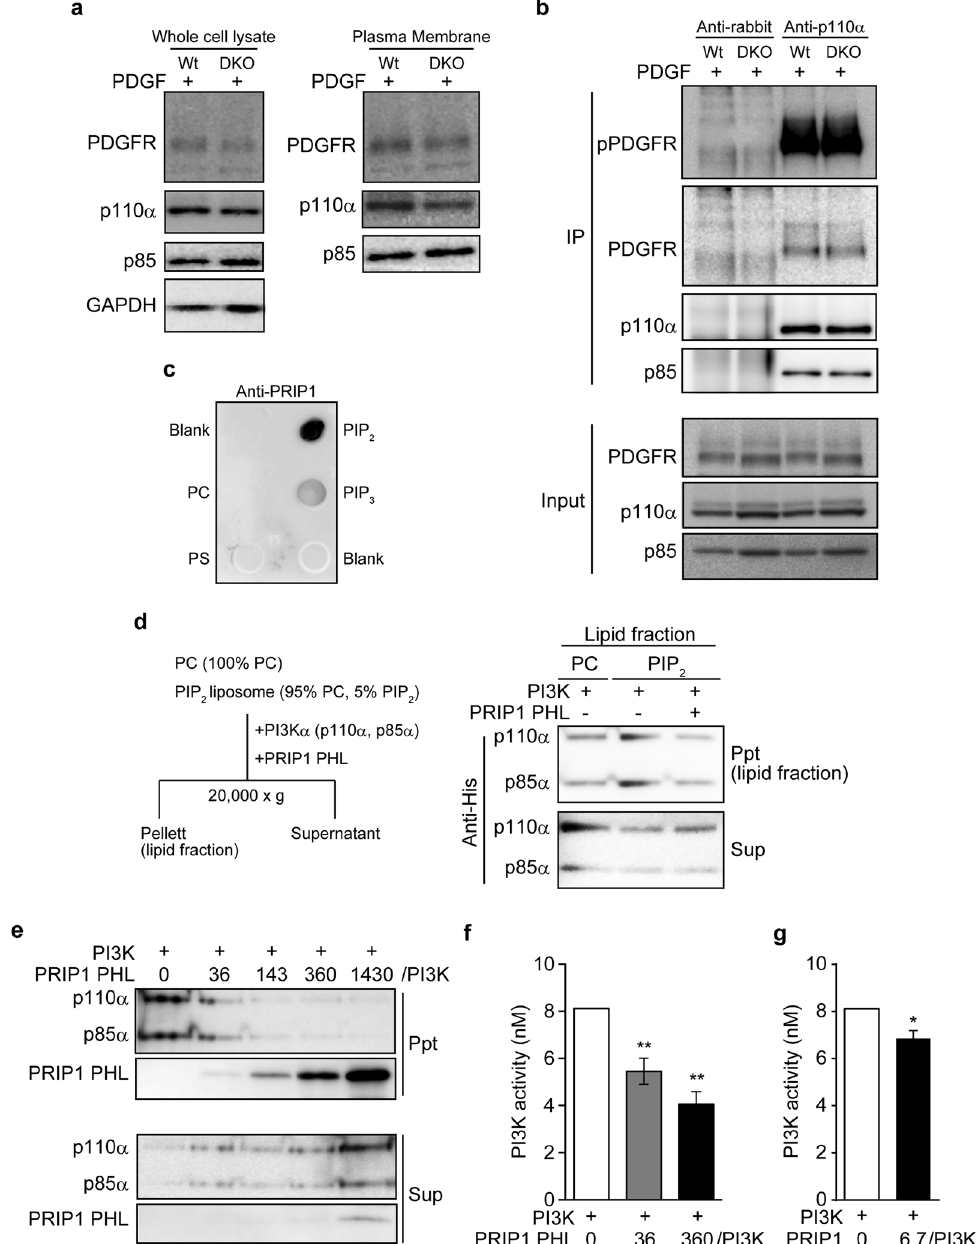
Figure 7. PRIP suppresses the conversion of PI(4,5)P 2 to PI(3,4,5)P 3 by PI3K. ( a , b ) MEFs were stimulated ( + ) with 20 ng/mL PDGF for 10 min. Treated cells were homogenised and fractionated by centrifugation ( a ) or lysed and immunoprecipitated (IP) with an anti-p110 α antibody ( b ). Western blotting was performed with the indicated specific antibodies. Similar data were obtained from at least three independent experiments, and a set of representative images is shown. ( c ) Specific binding of EGFP-PRIP1 to PI(4,5)P 2 . Indicated lipids were blotted on a polyvinylidene difluoride membrane. Signals were detected using anti-PRIP1 antibody. PIP 2 , PI(4,5)P 2 ; PIP 3 , PI(4,5)P 3 ; PC, phosphatidylcholine; PS, phosphatidylserine. ( d , e ) A PI(4,5)P 2 sedimentation assay was performed using recombinant His-tagged PI3K α in the presence ( + ) or absence ( − ) of recombinant PRIP1 PHL (see Supplementary Fig. S6a) ( d ), or in the presence of the indicated dose of the PRIP1 PHL ( e ). The method is schematically presented on the left in ( d ). Liposomes are composed of PI(4,5)P 2 : PC = 5:95 (molar ratio) (PIP 2 ) or 100% PC (PC). The obtained lipid fractions (ppt) and supernatants (sup) were evaluated by western blotting using an anti-His antibody (for PI3K α ) and anti-GST antibody (for PRIP1 PHL). Similar data were obtained from three independent experiments, and representative images are shown. (f , g) Metabolic activity of PI3K α in the production of PI(4,5)P 3 in the presence of PRIP1 PHL ( f ) or recombinant PRIP1 (Supplementary Fig. S6b) ( g ). The data are presented as means ± SEM [( f , g ) n = 3 for each indicated experiment]. * p < 0.05, ** p < 0.01 versus the control without PRIP1 PHL ( f ) or PRIP1 ( g ) [Kruskal–Wallis test followed by Dunn’s multiple comparison test ( f ) or Mann–Whitney U test ( g